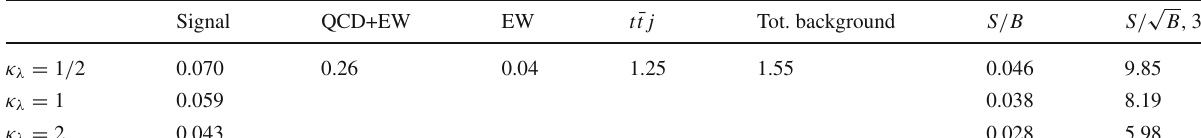
Table 2 Results of the fully leptonic tau decay channels outlined in Sect. 2.2 in femtobarns (numbers to the left of the double vertical lines) after an optimised cut on the BDT output. We include results